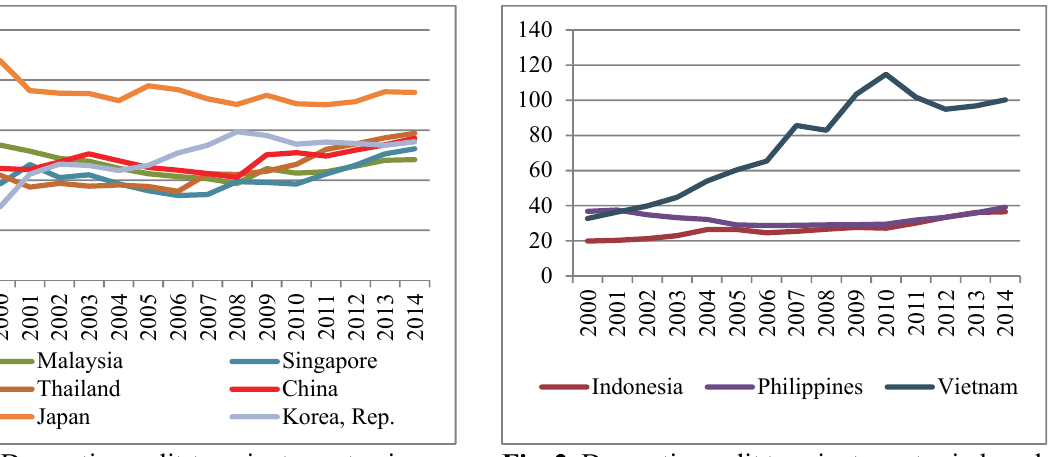
Fig. 2. Domestic credit to private sector in less de- veloped financial systems (% of GDP)